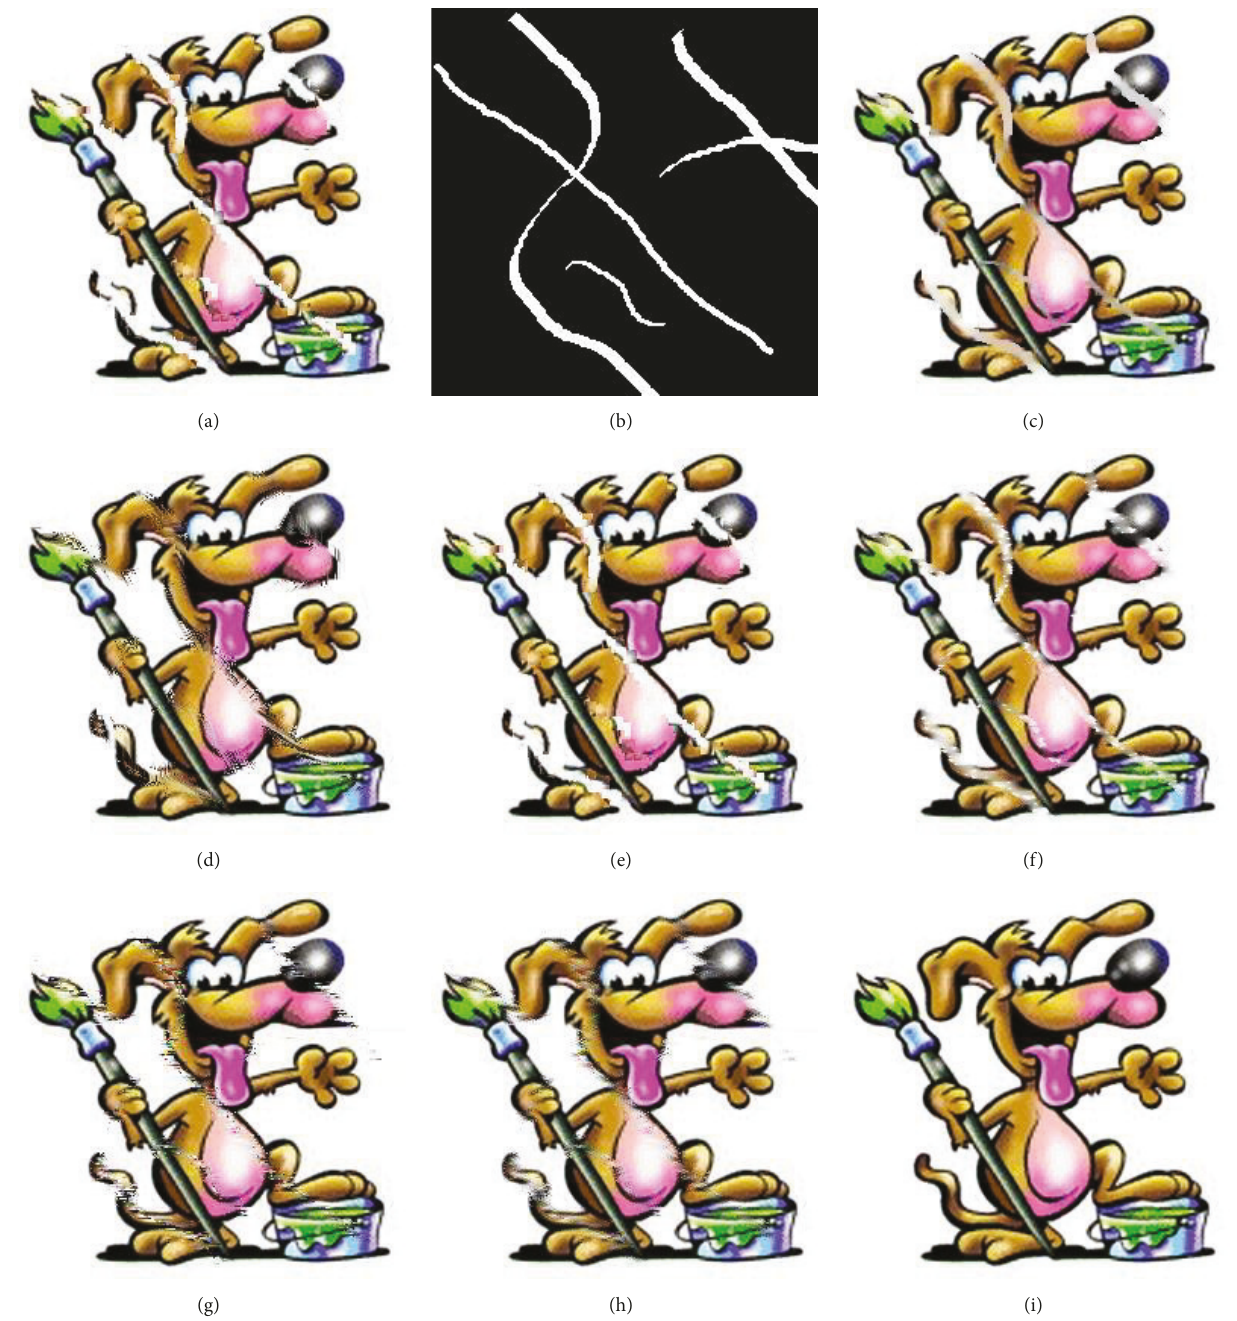
Figure 8: Repaired cartoon images by different inpainting methods. (a) The damaged image; (b) the mask image; (c) by BSCB; (d) by CT; (e) by EB; (f) by TV; (g) by Thiele; (h) by our method; (i) the original